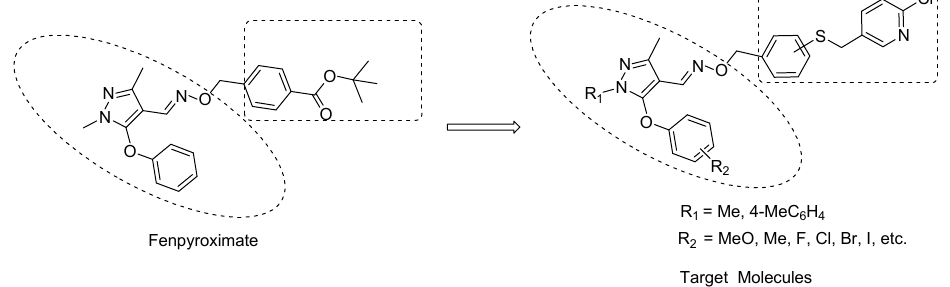
Figure 2. The design of the title molecules.